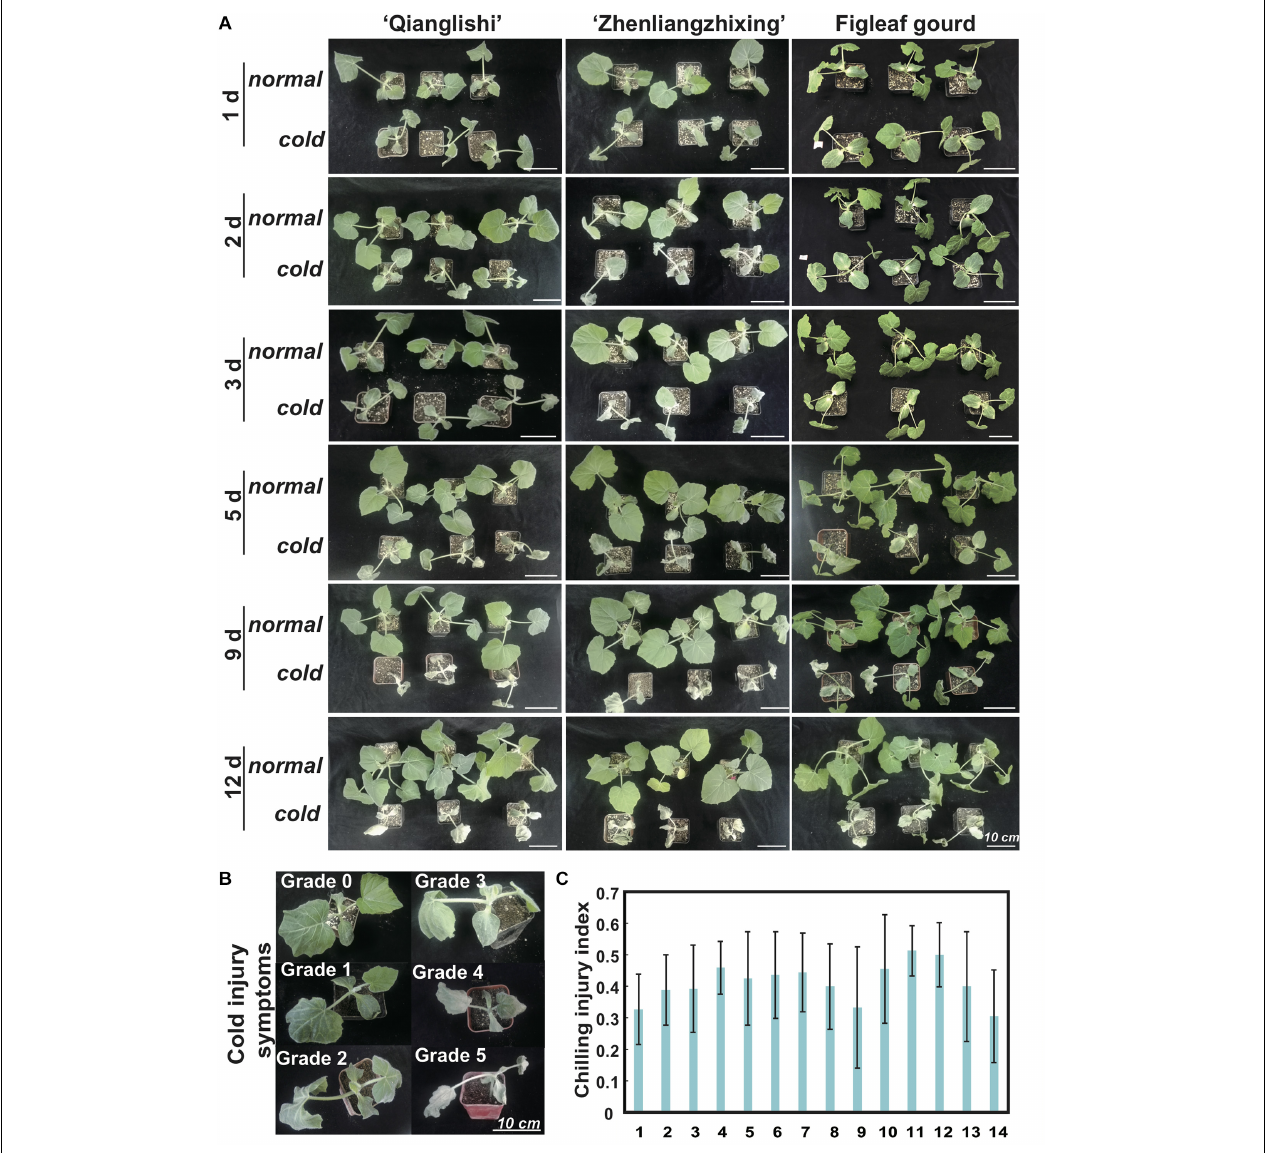
FIGURE 1 | Seriousness of cold-injury symptoms vary between pumpkin rootstock varieties. (A) Phenotypic changes in three selected pumpkin rootstocks, “ Qianglishi ,” “ Zhenliangzhixing ,” and figleaf gourd , after different periods of chilling (4 ◦ C). Chilling treatments were applied to 100 seedlings in each of three biological replicates at the two-true-leaf stage. Another 100 seedlings in each of three biological replicates were kept in normal growth conditions. Symptoms were observed every day to evaluate the chilling injury of different varieties. (B) Chilling injury symptoms of pumpkin rootstock seedlings “ Qianglishi ” were evaluated using the chilling injury index (CII) classification (Semeniuk et al., 1986) after 3 d of chilling. Grade 0: no symptoms of injury. Grade 1: the edges of first leaves are yellow or slightly dehydrated. Grade 2: dehydration spots appear in a small part of the first leaves; the other leaves are slightly dehydrated. Grade 3: dehydration spots appear in half of the first leaves; the other leaves are slightly dehydrated. Grade 4: dehydration spots appear in most of the leaf area; half of the other leaves are dehydrated. Grade 5: almost all leaves are seriously dehydrated and wilted. (C) CII statistics in 14 pumpkin rootstock varieties. The detailed information of different numbers representing different pumpkin commercial varieties was listed in Material and Method part. Error bars indicate